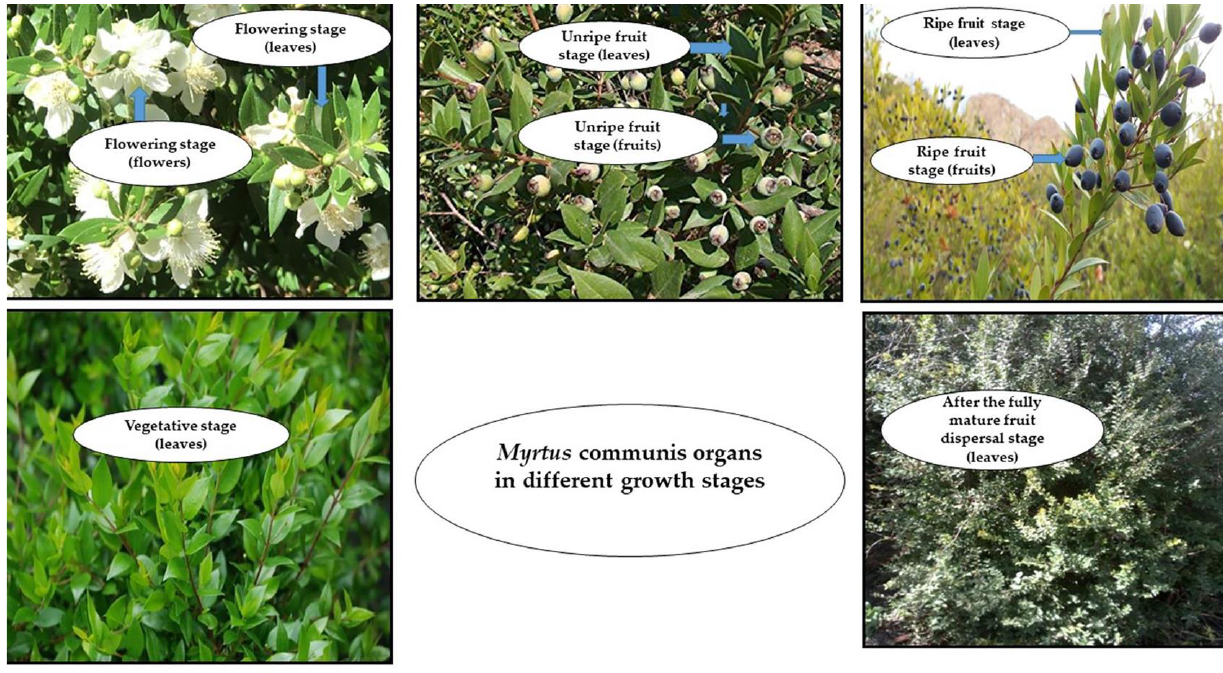
Figure 1. Myrtus communis organs in different phenological